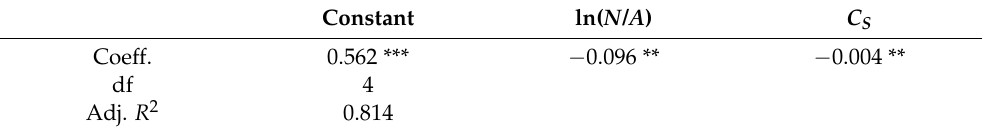
Table 5. Estimated regression parameters of the recreation value model (Equation (20)).